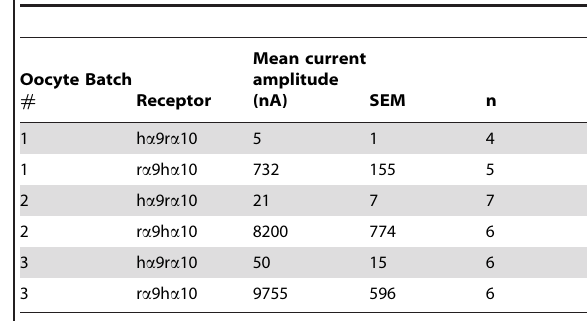
Table 1. Comparison of the functional expression of receptors following co-injection of cRNA for subunits of different species. a